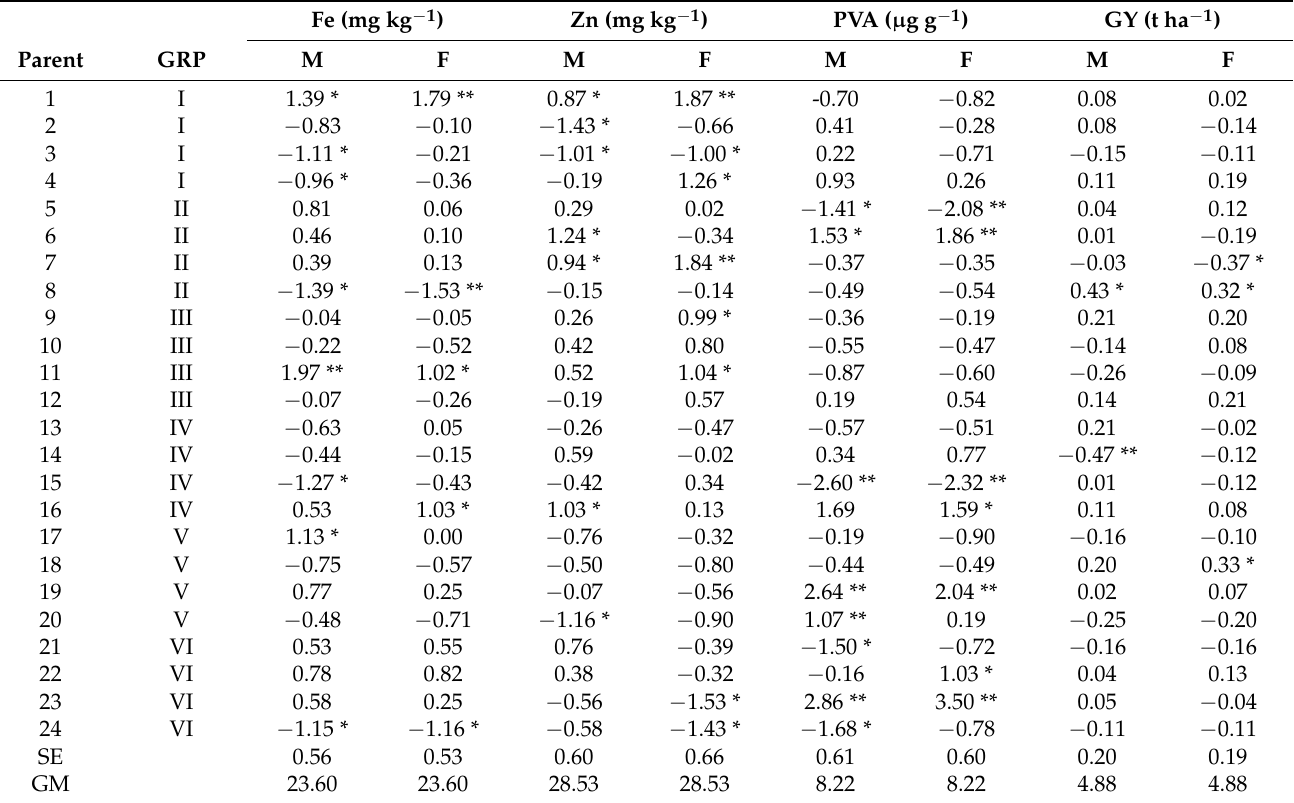
Table 4. Estimates of general combining ability effects for Zinc, Iron, PVA and grain yield for 24 parental inbred lines used to form 96 hybrids evaluated across four